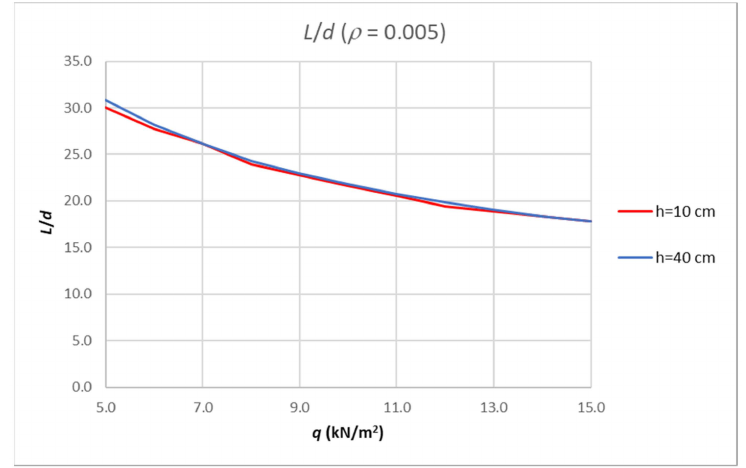
Figure 11. Results of analysis-limit span to depth ratio depending on amount of load for fixed reinforcement ratio and different height of cross-section. Table 9. Results of parametric analysis.